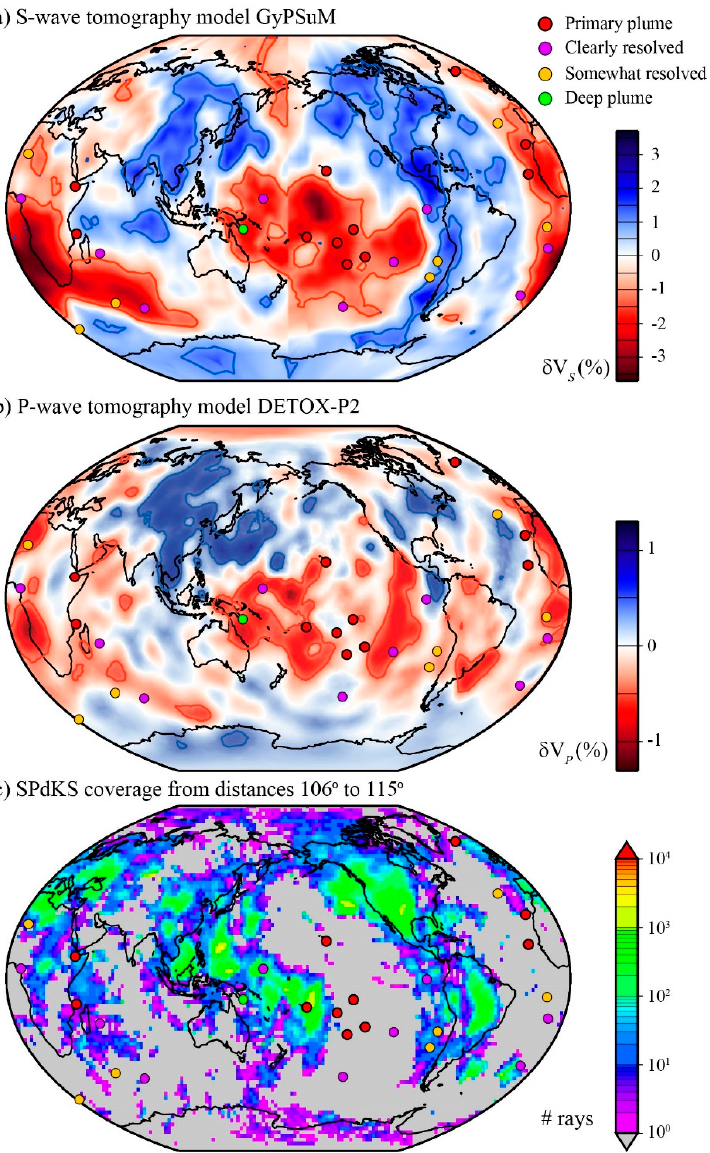
Figure 5. ( a ) S-wave tomography model GyPSuM [42] at the core-mantle boundary. Contours are drawn for reference at the − 1% (red) and +1% (blue) S-wave velocity levels. In all panels, the locations of possible deep mantle plumes from French and Romanowicz [41] are indicated as per their ability to resolve a plume conduit from surface to CMB. The resolvability is in the order: (1) primary plume—red circle, (2) clearly resolved—purple circle, and (3) somewhat resolved—yellow circle. The final classification of deep plume indicates a possible deeply seated plume with no hotspot surface expression. ( b ) P-wave tomography model DETOX-P2 [43]. Contours are drawn at the − 0.4% (red) and +0.4% (blue) P-wave velocity levels. ( c ) Coverage of SPdKS + SKPdS rays on the CMB in the epicentral distance range 106° ≥ Δ ≥ 115° and Signal to Noise Ratio (SNR) ≥ 4.0. Coverage with at least one single seismic ray in 2° × 2° grid on the CMB. Total coverage is 56.9% of the surface of the CMB.